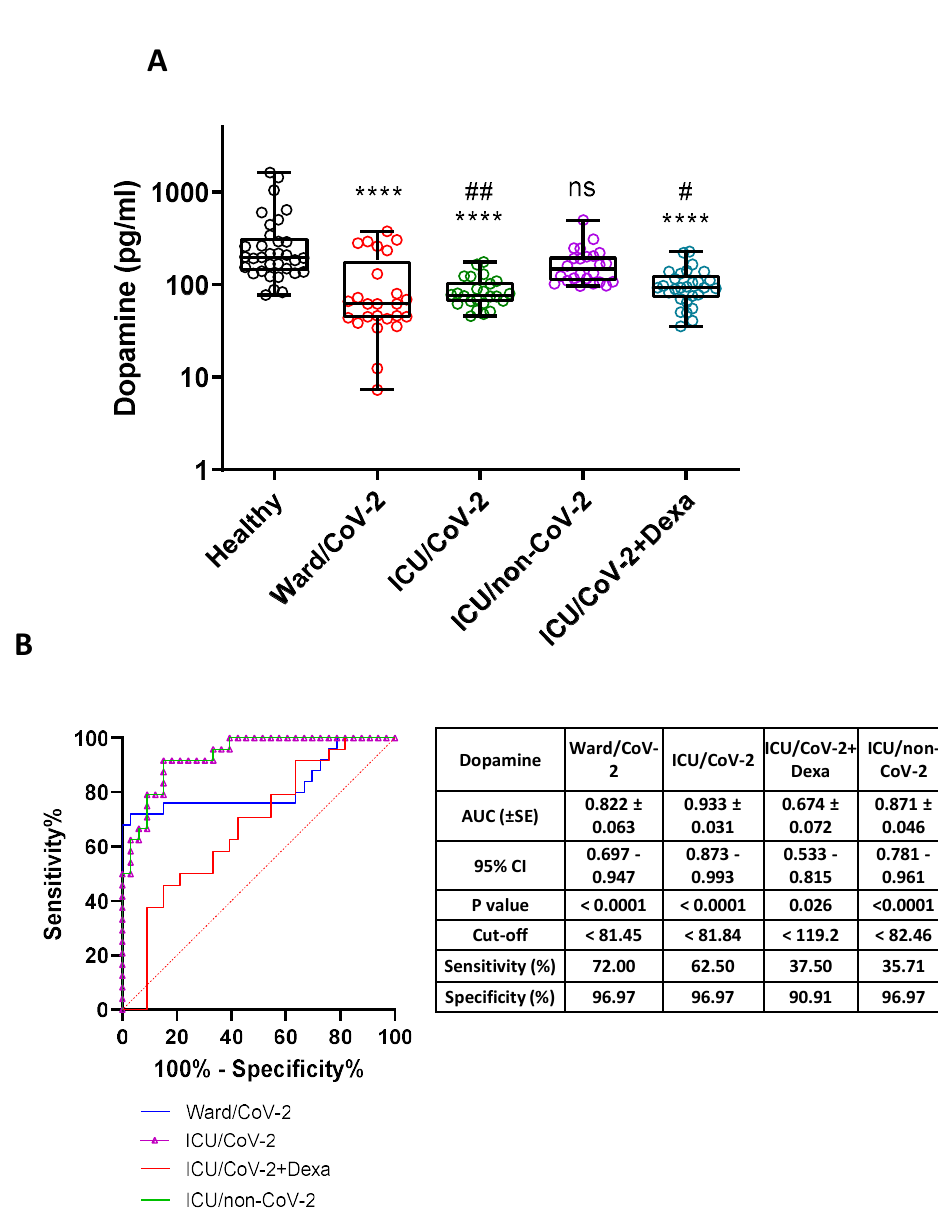
Figure 6. SARS-CoV-2 infection affects serum dopamine levels in COVID-19 hospitalized patients: ( A ) Comparison of dopamine absolute levels in healthy subjects (Healthy), COVID-19 patients hospitalized in the ward (Ward/CoV-2), ICU COVID-19 patients (ICU/CoV-2), SARS-CoV-2 negative ICU patients (ICU/non-CoV-2), and ICU COVID-19 patients who had received dexamethasone treatment (ICU/CoV-2 + Dexa). p -values were determined by the Kruskal–Wallis test. The Dunn’s test was performed for multiple comparisons. Data are displayed as box plots; the line in the middle, median; box edges, 25th to 75th centiles; whiskers, range of values. ( B ) ROC curve analysis of dopamine quantitation using the Healthy cohort as a control. ROC curves were generated, and AUC, 95% CI, p -values, and cut-off points with their specificity and sensitivity were reported. The red dotted line denotes perfect chance (positive likelihood ratio = sensitivity/(1-specificity) =1). **** p < 0.0001 vs. Healthy, # p = 0.029, ## p = 0.0018 vs. ICU/non-CoV-2, ns: not significant vs. Healthy.